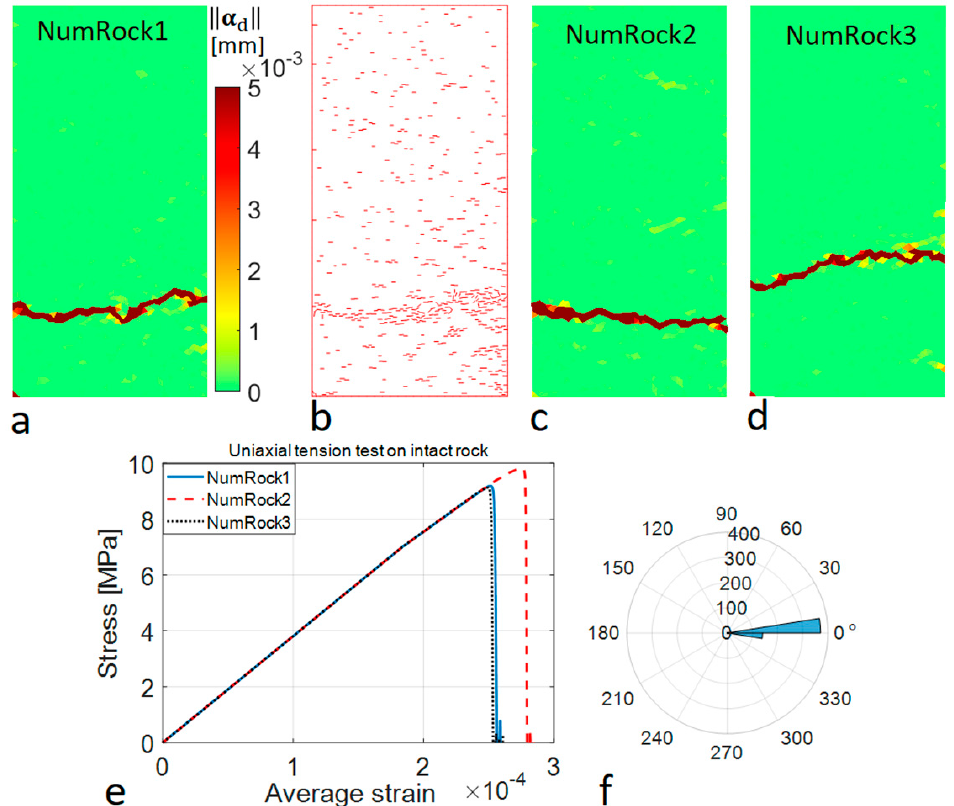
Figure 6. Simulation results for uniaxial tension test (intact rock): ( a ) crack opening magnitude with NumRock1; ( b ) cracks with NumRock1; ( c ) crack opening magnitude with NumRock2; ( d ) crack opening magnitude with NumRock3; ( e ) average stress–strain curves; ( f ) polar histogram showing crack orientation angles (565 cracks) with NumRock1.